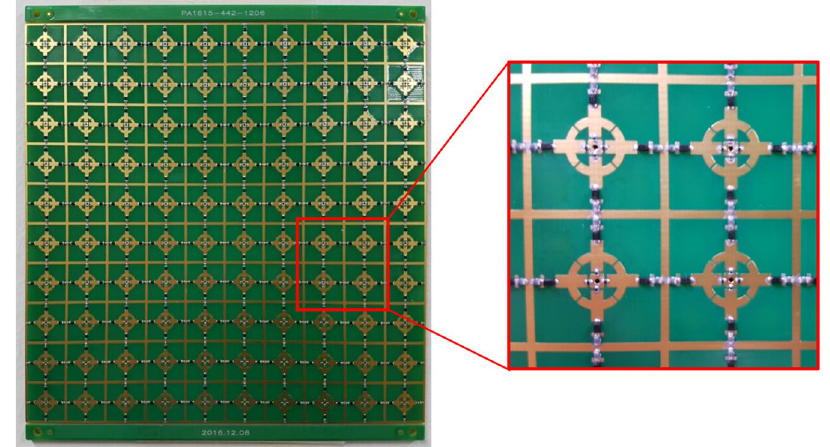
Figure 2. Fabricated prototype sample.